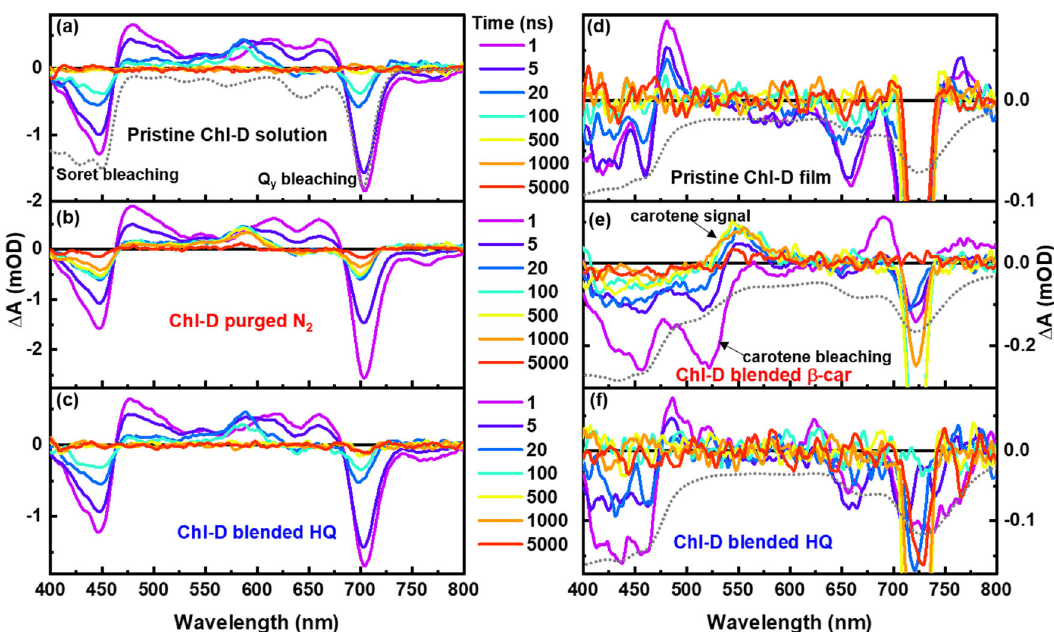
Fig. 4 Photo-induced TA spectra of Chl-D solution and fi lm. a Pristine Chl-D solution and the ones ( b ) purged with N 2 gas or ( c ) blended with HQ excited at 650 nm ( Q y band of Chl-D solution), and the TA spectra of Chl-D fi lm which included ( d ) neat Chl-D fi lm and the ones blended with (e) β -carotene or (f) HQ excited at 737 nm ( Q y band of Chl-D fi lm). The gray broken-dotted line represents the inverted steady-state absorption spectrum of each sample for comparison.